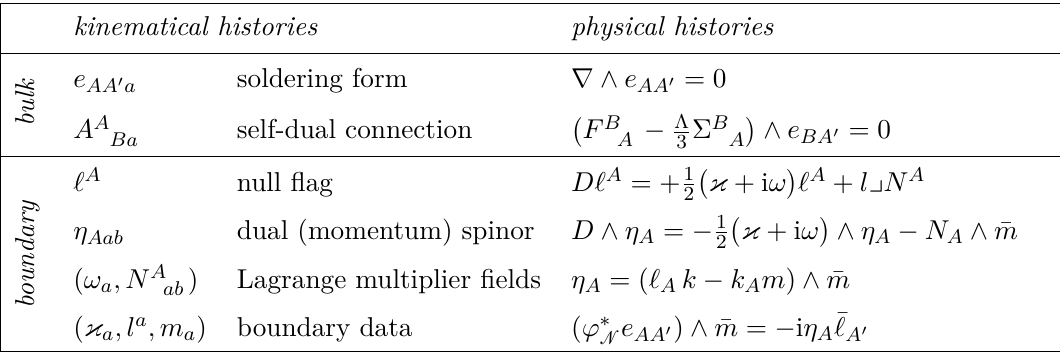
Table 1 . The action is a functional on the space of kinematical histories. Its saddle points define the space of physical histories H phys ⊂ H kin , which consists of all solutions of the bulk plus boundary field equations, which are given by the Einstein equations in the bulk, and additional boundary field